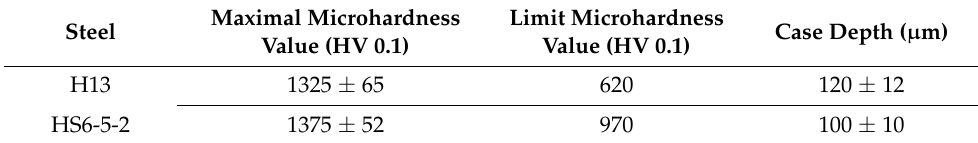
Table 5. Properties of the nitrided layers.